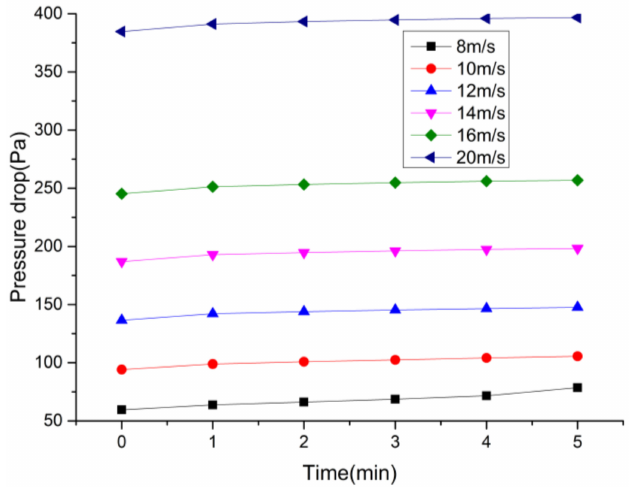
Figure 19. Pressure drop at different flow rates.